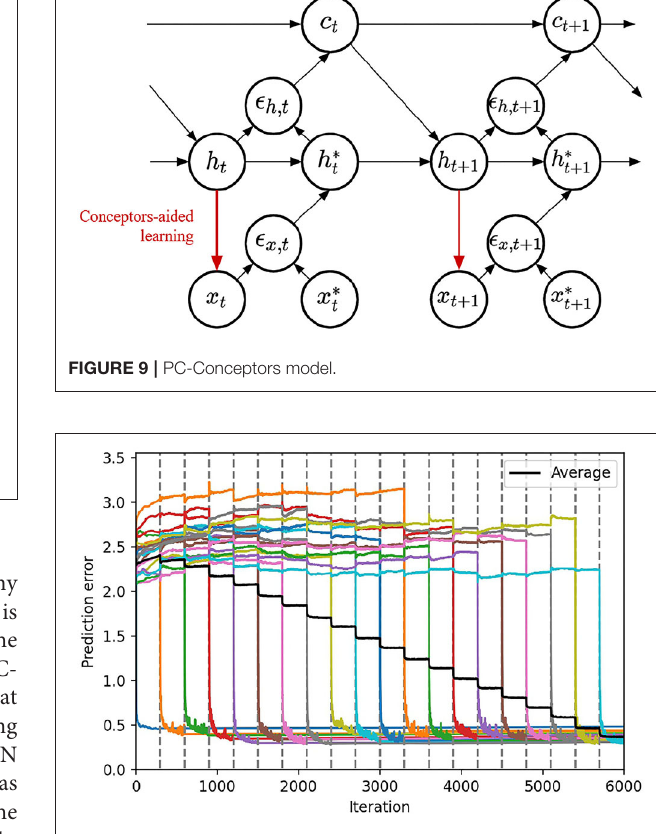
FIGURE 10 | Continual learning results using the PC-Conceptors. We represent the average prediction error over 10 seeds, for the continual learning of 20 sequential patterns, using the PC-RNN-HC-A model with Conceptors. The colored lines correspond to the prediction error on each individual task, and the black line corresponds to the prediction error averaged on all tasks. The 20 tasks are delimited by the dashed gray